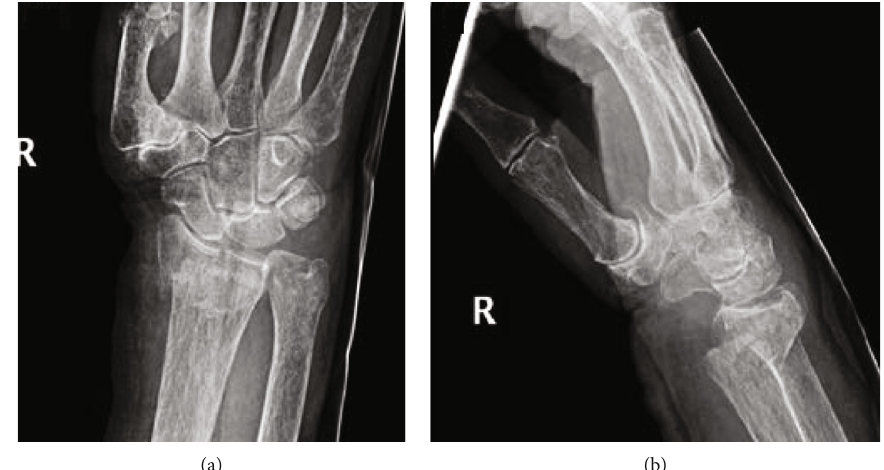
Figure 3: Plain radiographs of the right wrist in the (a) AP and (b) lateral views showing a dorsally displaced distal radius fracture with intra-articular